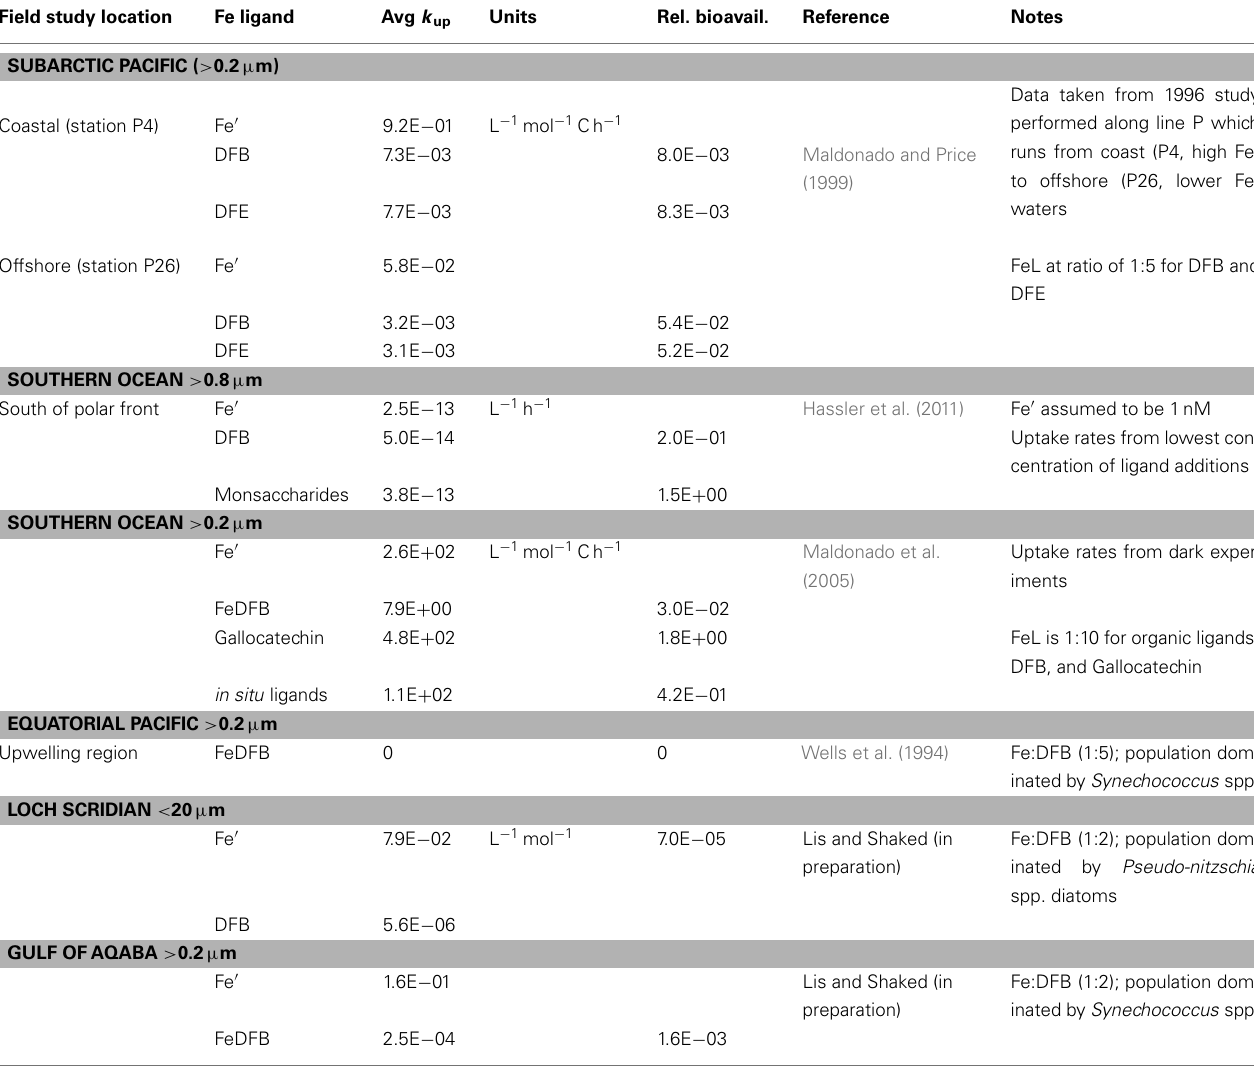
TableA4 | Data used in the calculation of relative bioavailability of natural assemblages (Figure